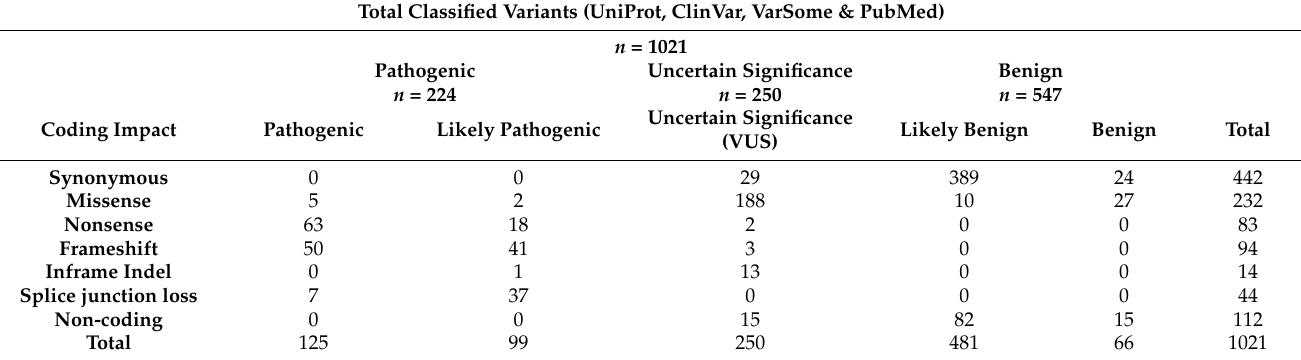
Table 1. Genetic variants detected in the EVC2 gene with known pathogenicity. Total Classified Variants (UniProt, ClinVar, VarSome &